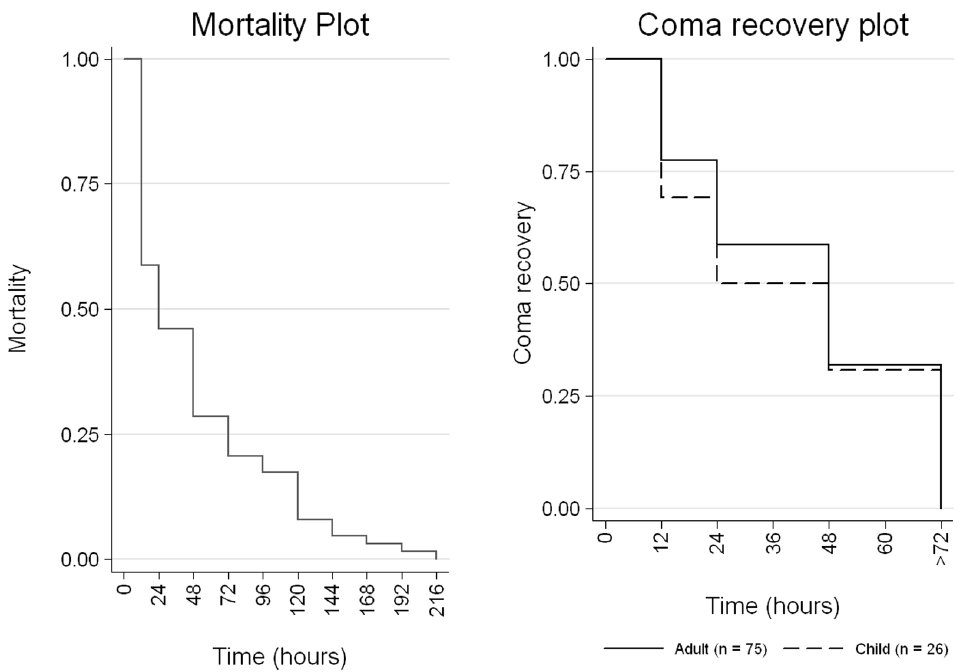
Fig. 3. Time period wise coma recovery and mortality pattern of P. falciparum associated complicated malaria cases in a tertiary care hospital in Bastar, Chhattisgarh, Central